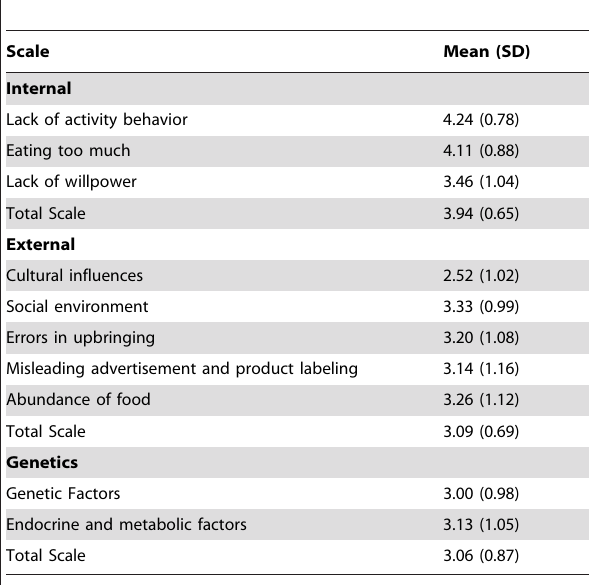
Table 5. Mean agreement rate for each potential cause of